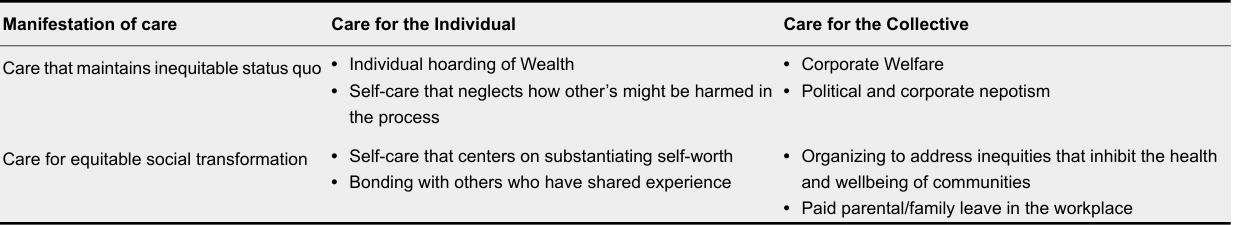
Example Manifestations of Care Ethics That Either Maintain or Challenge Inequity